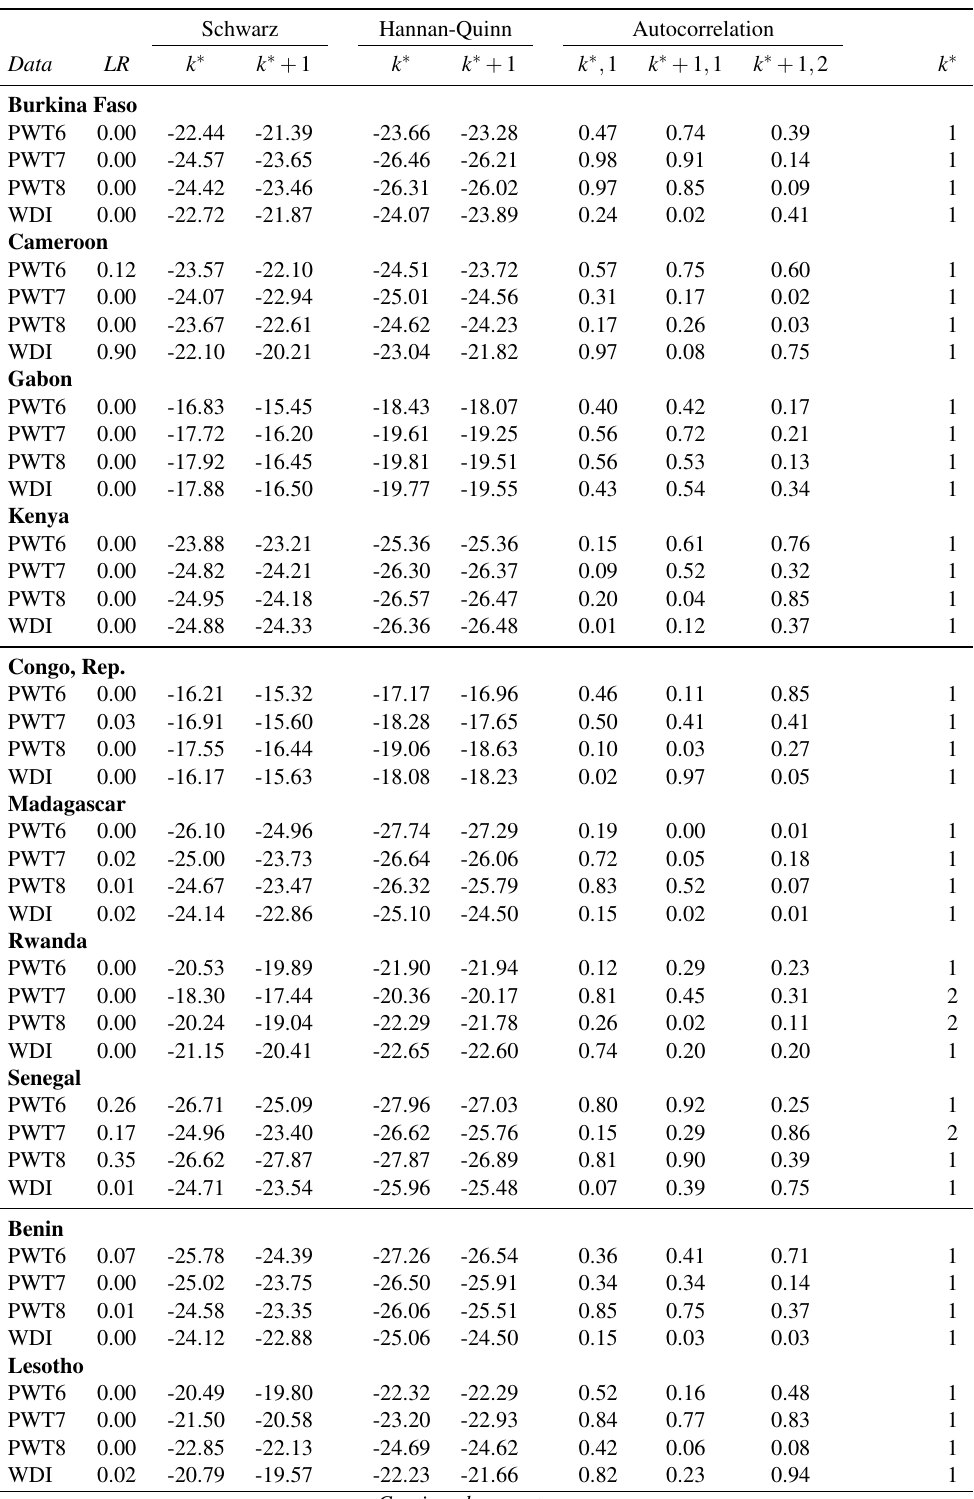
Table 6: Criteria for the choice of the lag-length Schwarz